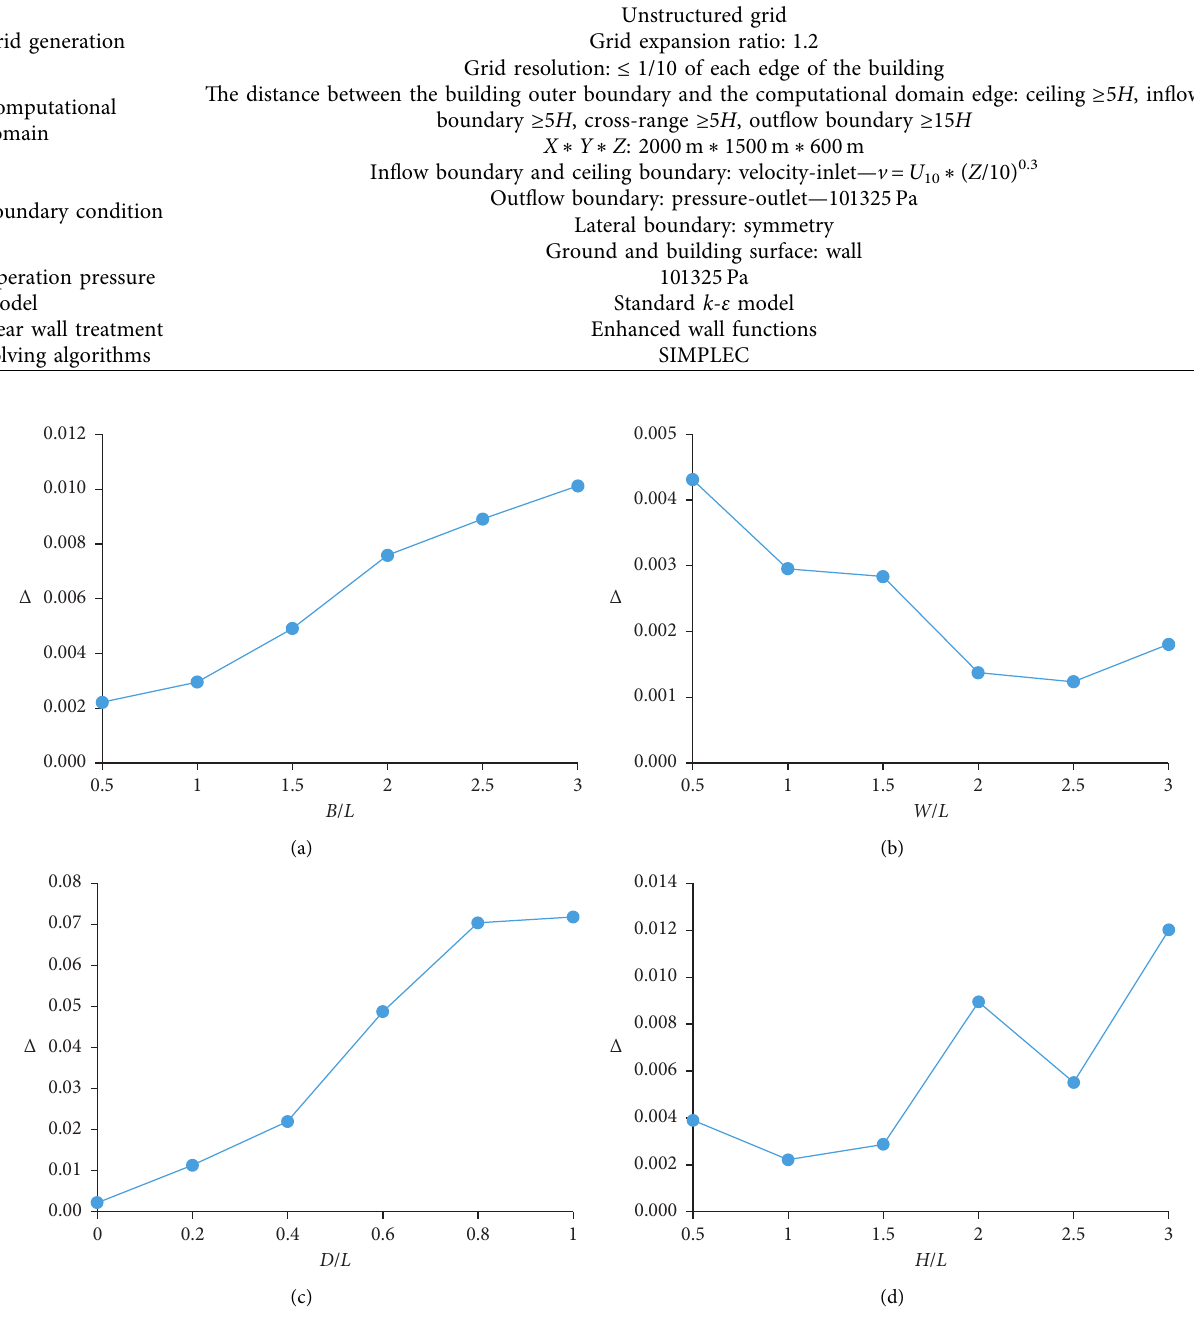
Table 3: Simulation settings in ANSYS Fluent.